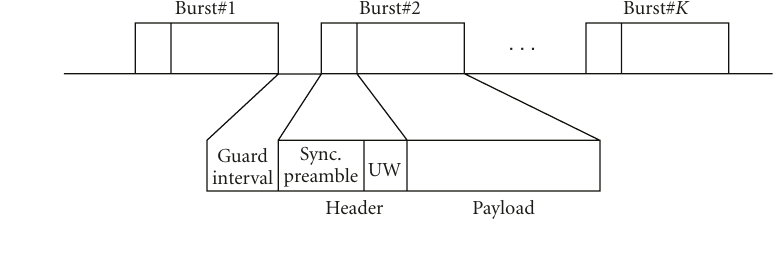
Figure 1: Burst structure.